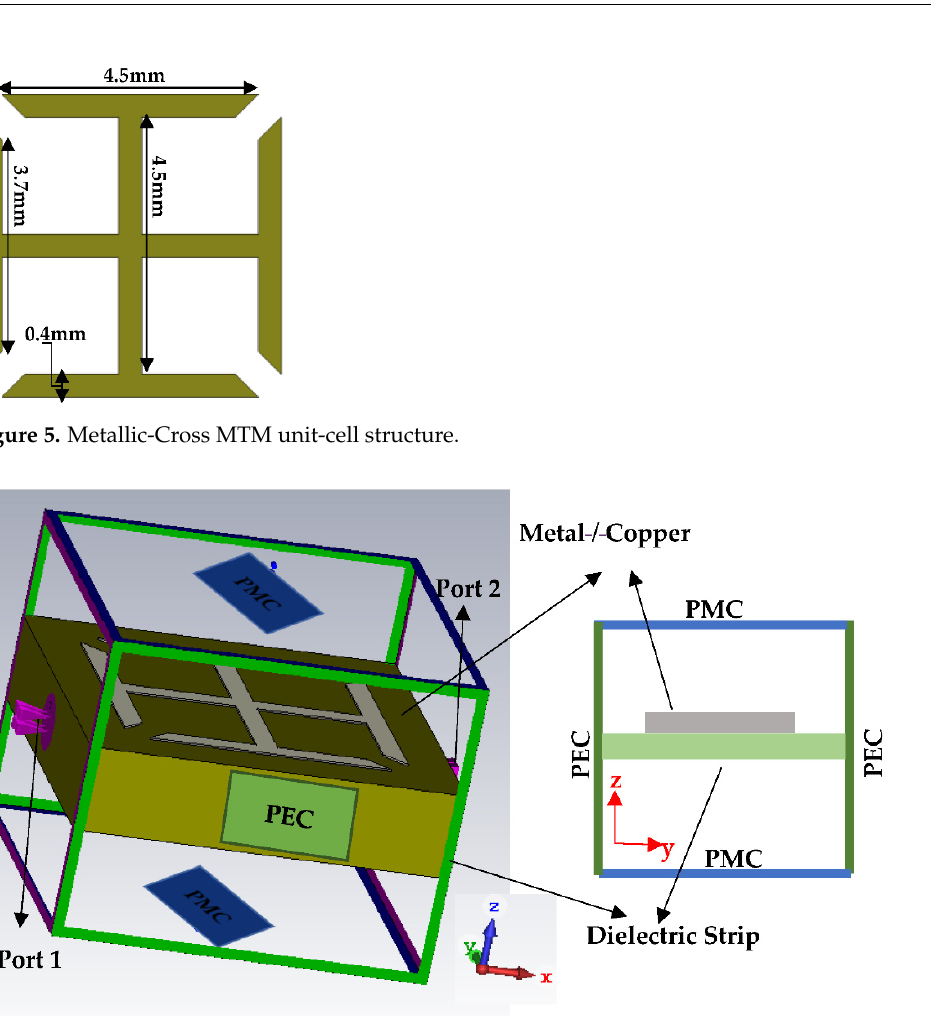
Figure 6. Boundary conditions and excitations applied to a single unit-cell.